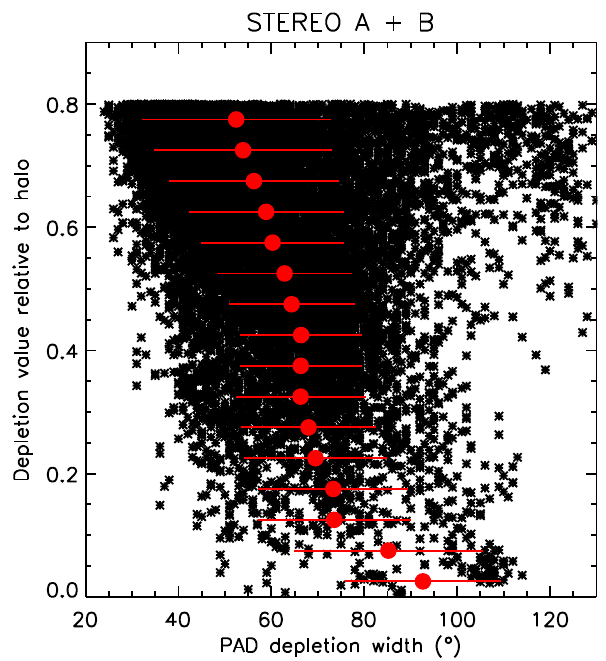
Fig. 6. Scatter plot of the full width at half maximum (FWHM) of the depletion in electron PA distributions as a function of the de- pletion value (cf. Fig. 3 and text for details), for ST-A and ST-B combined. Average values of the FWHM (red dots), with standard deviations (horizontal red lines), are shown as a function of the de- pletion value (bin size of